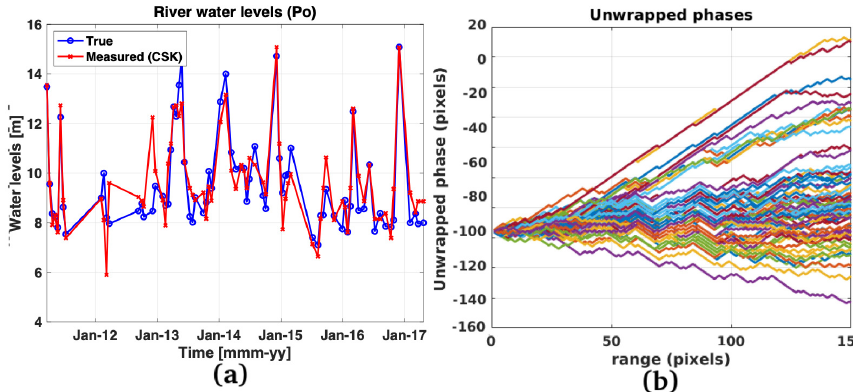
Figure 10. Case study 1 experimental measurements. ( a ): Water levels observed by the ground measurement station (blue line) and by the satellite (red line). ( b ): Unwrapped phases.